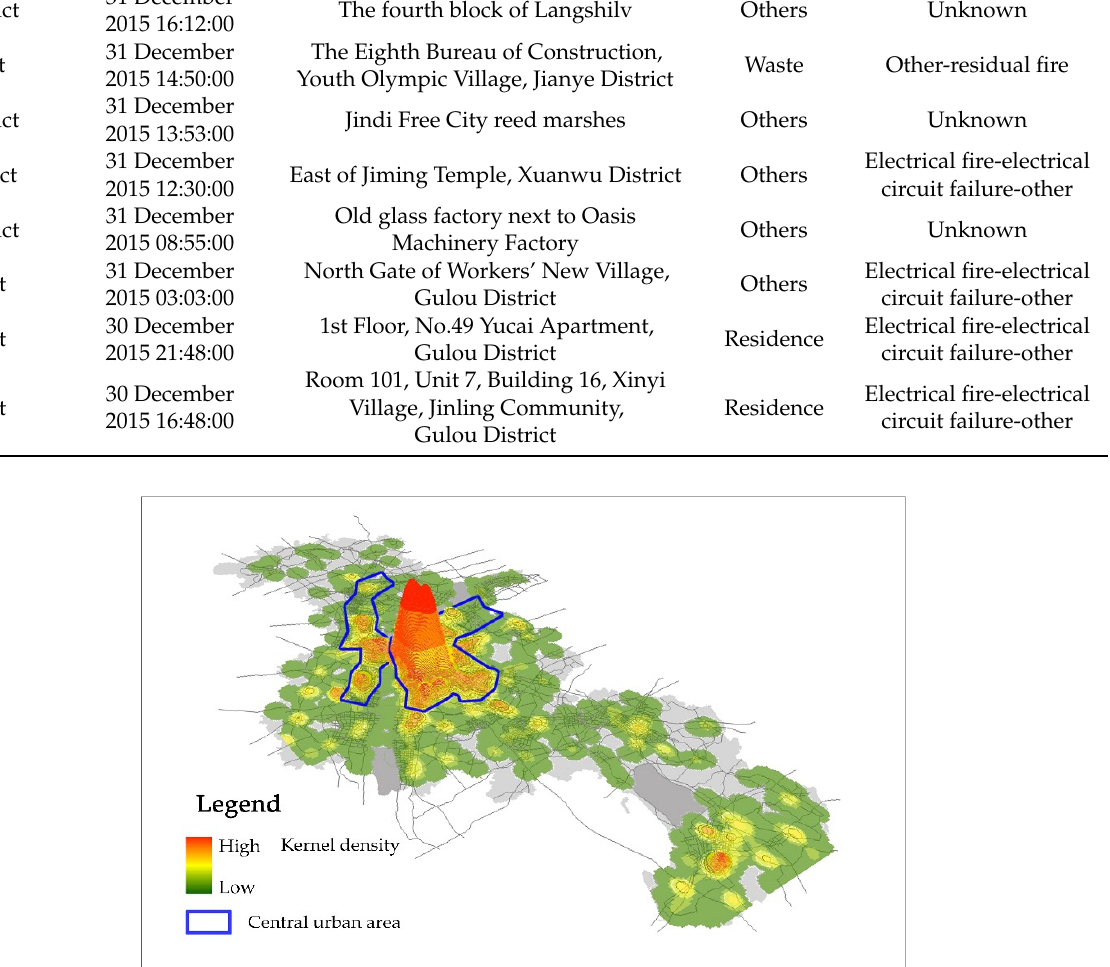
Figure 4. Fire outbreak distribution (3D view).